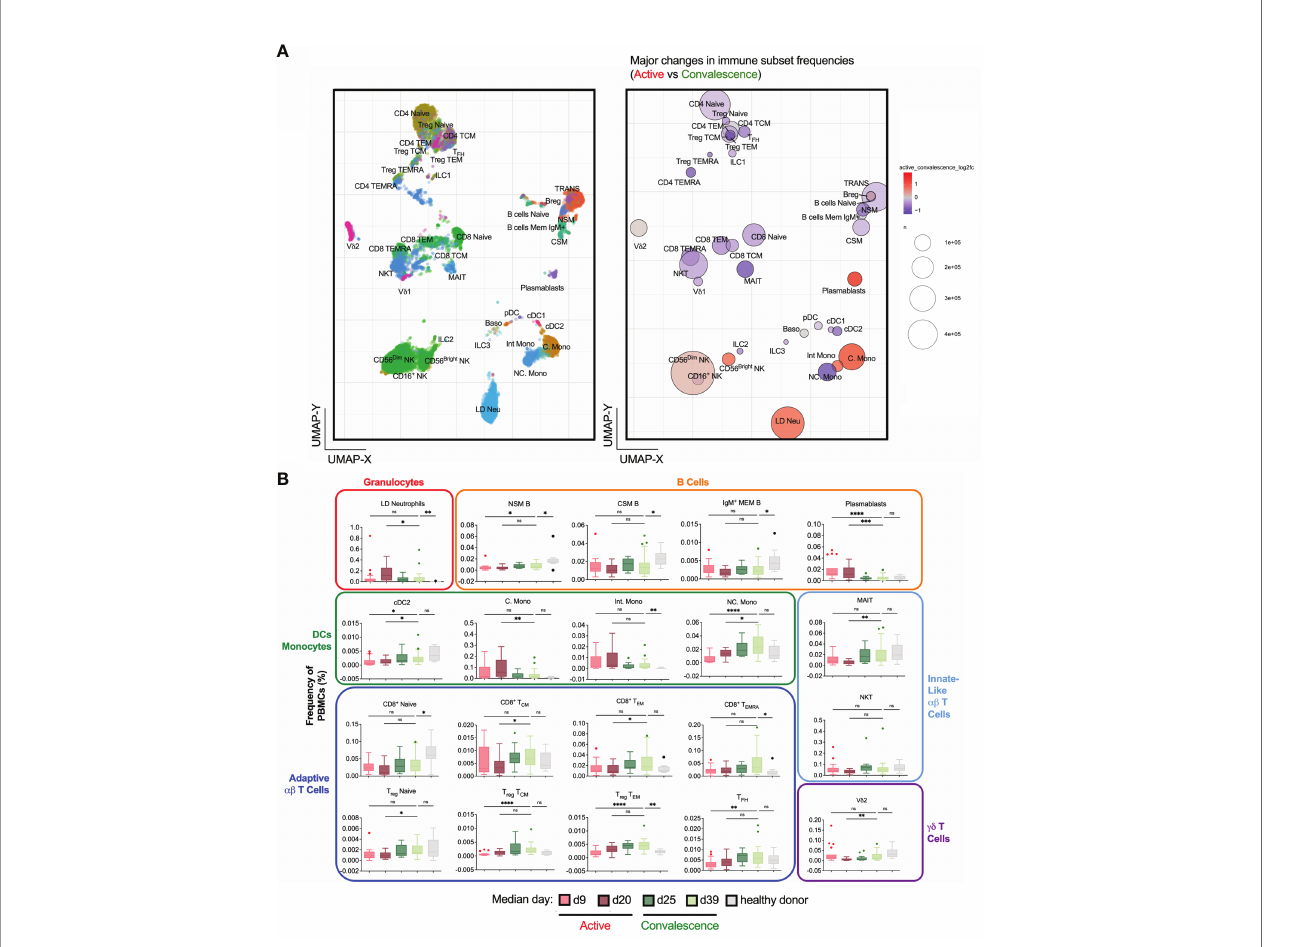
FIGURE 2 | Frequency changes in 38 basic immune cell populations with SARS-CoV-2 infection. (A) Uniform Manifold Approximation and Projection (UMAP) plots of 38 main immune cell populations detected by mass cytometry (left). Right: Bubble representation of fold changes in the detected populations during activeinfection relative to convalescence, with color-coding done on a log2 scale, and bubble size re fl ecting the percentage of the subset. (B) Frequency-time plots of immune cell populations of interest over the course of disease. Asterisks indicate statistical signi fi cance- ns, not signi fi cant, *p < 0.03; **p < 0.002; ***p < 0.0002, ****p < 0.0001 (Kruskal-Wallis test with multiple comparison corrected on each disease phases versus healthy